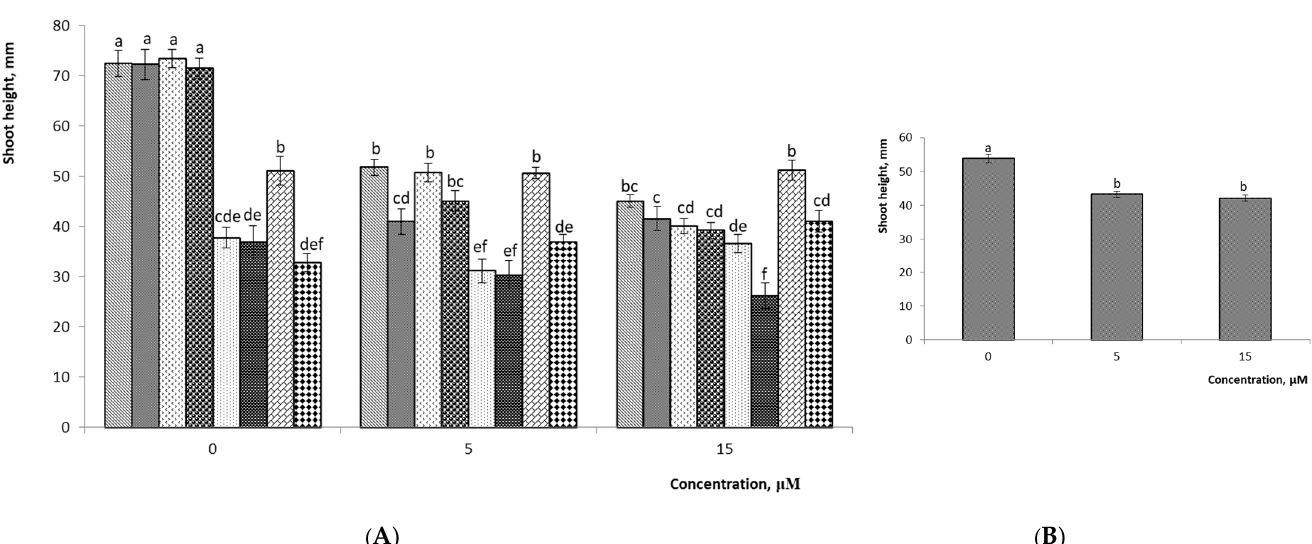
Figure 5. Effect of 2iP concentration on the multiplication rate of V.ul. 8 x ‘SC 5-8’: ( A ) detailed analysis of values of hybrid variants; ( B ) average values of hybrid variants. Means followed by the same letter are not significantly different according to the LSD at p ≤ 0.05. Note: 6-2, 7-3, 7-9—variant Nos. 6-2, 7-3, 7-9.